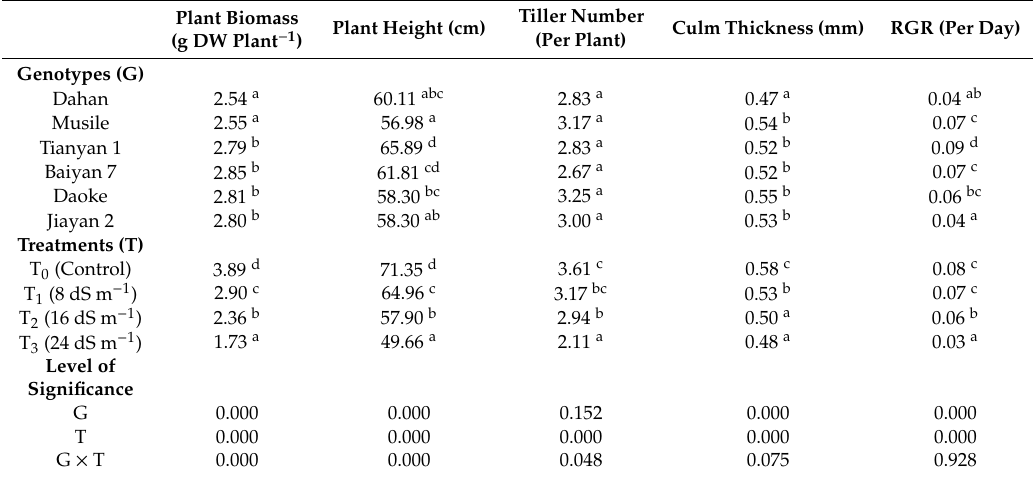
Table 1. E ff ect of various levels of salinity on plant biomass, plant height, tiller number per plant and culm measurements, while treatment values are the means of the 18 measurements. Means followed by di ff erent letters are significantly di ff erent ( p < 0.05) according to Tukey’s-b